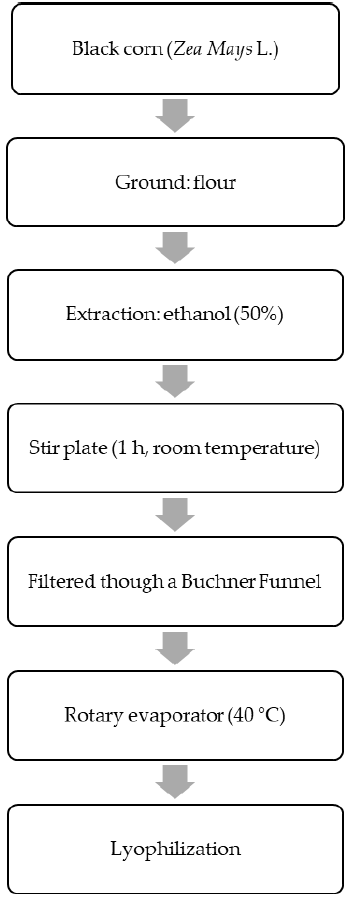
Figure 1. Flowchart of the black corn extract procedure.